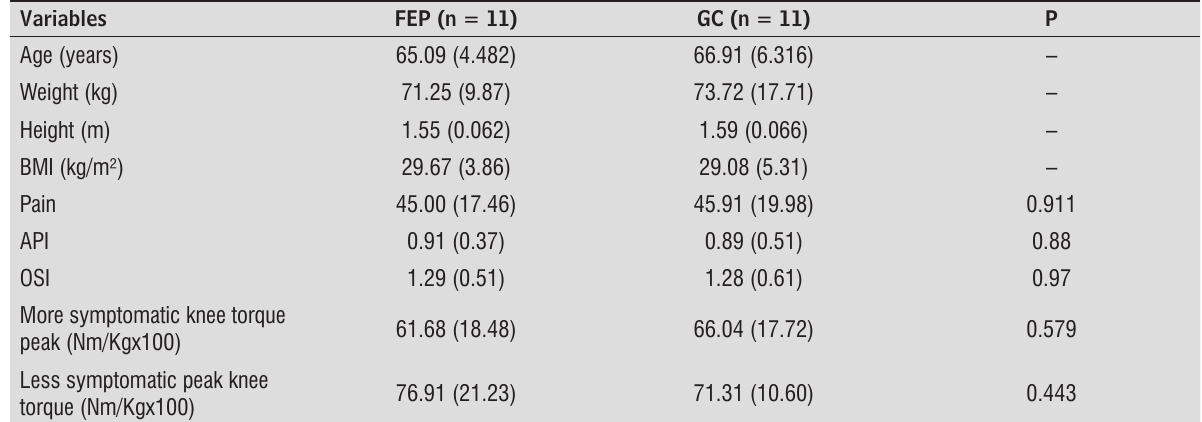
Table 2 - Characterization of the